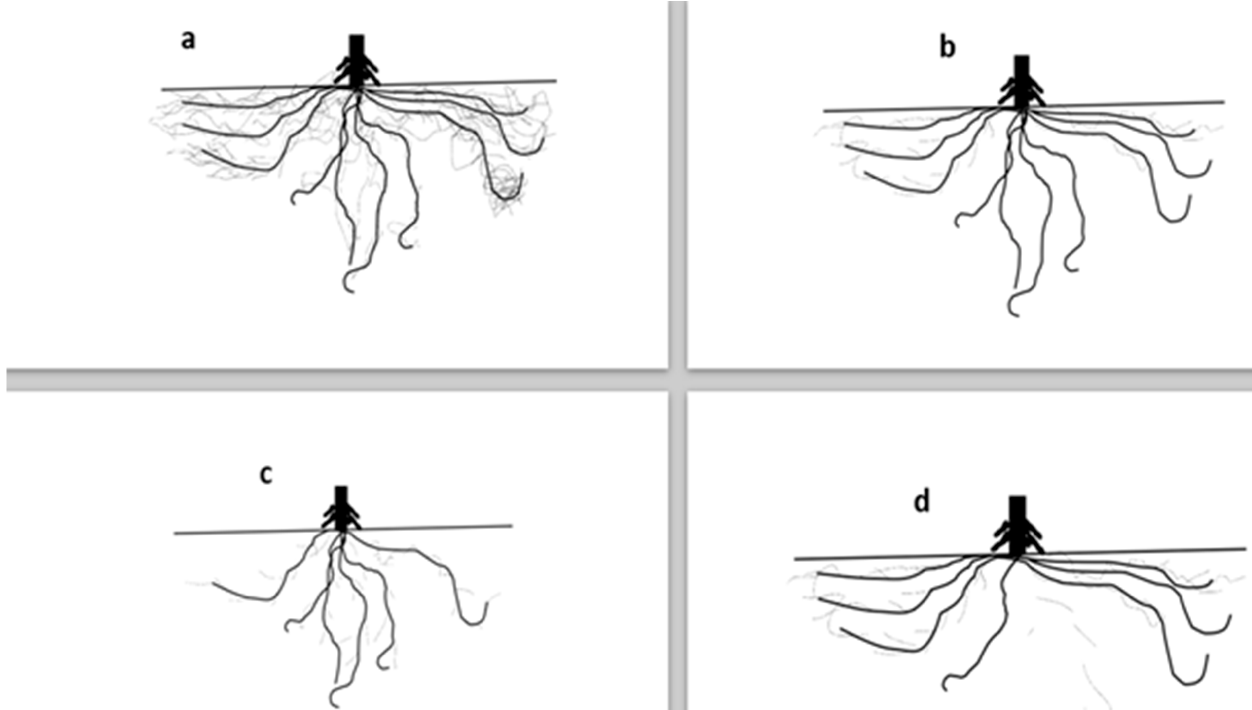
Figure 1. Maize roots with different morphological and physiological architecture; ( a ) maize roots with good root hair, vertical and horizontal architecture; ( b ) maize roots with good vertical and horizontal root architecture; ( c ) maize roots with good vertical root architecture; ( d ) maize roots with good horizontal root architecture (image prepared by Dr. Isaac K. Mpanga).